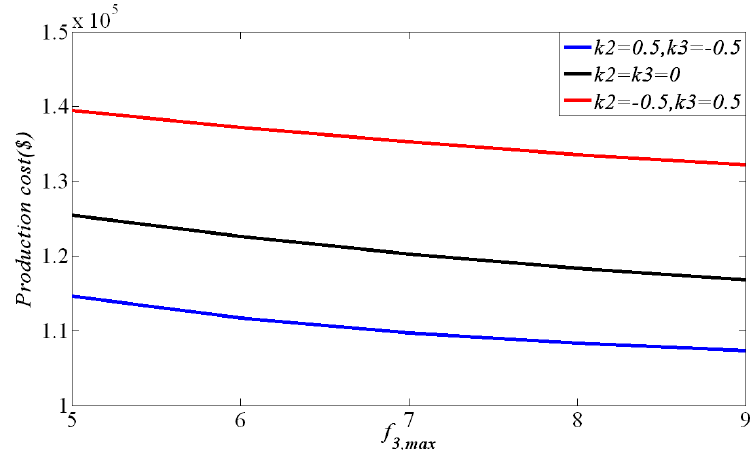
Figure 6. Production cost under different preference factor values.